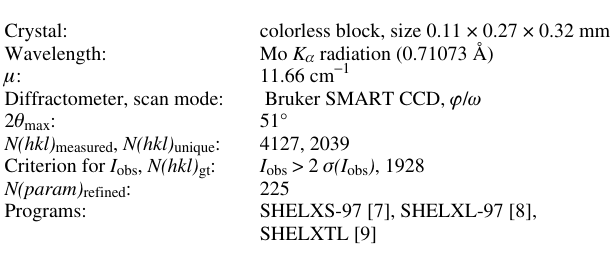
Table 1. Data collection and